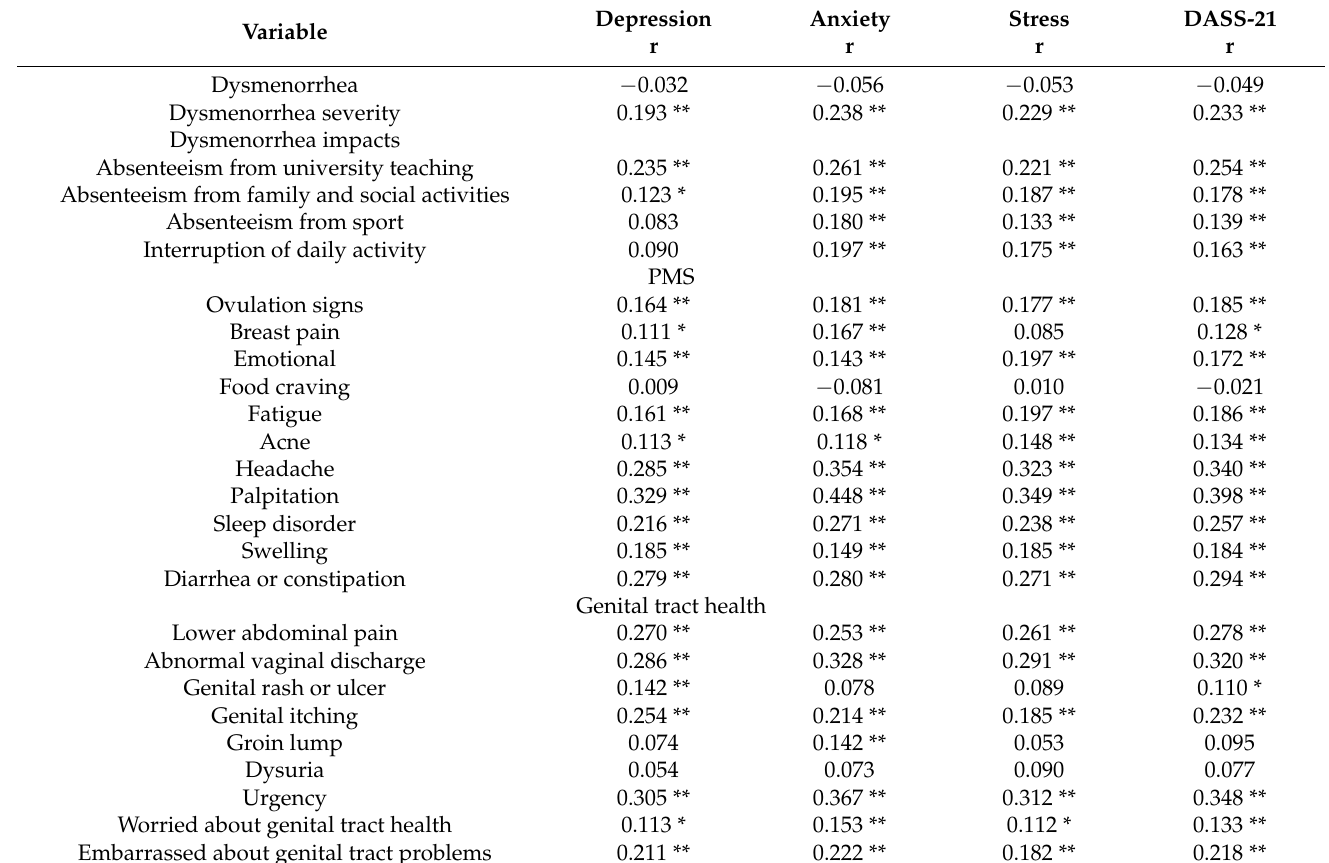
Table 4. After COVID-19 Pearson correlation coefficients (r) for the relationship between dysmenor- rhea, PMS, and genital/urinary symptoms with Depression, Anxiety and Stress Scale-21 (DASS-21) or